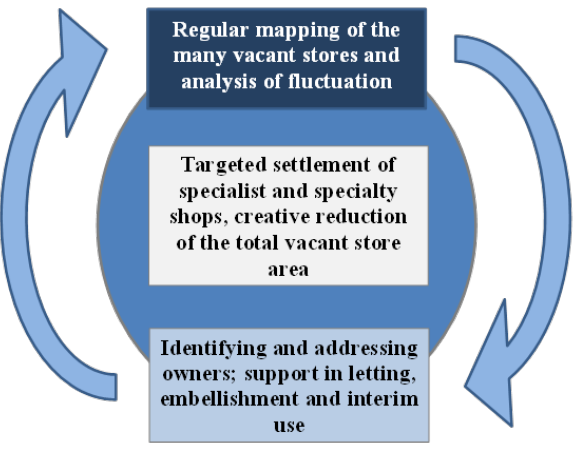
Figure 4: Examples of transformative methods in the project “Strengthening Local Economy in the Viersener